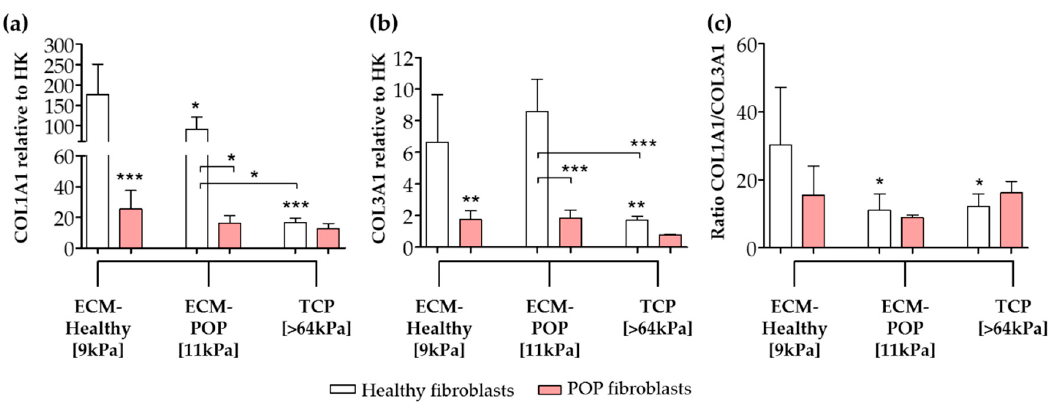
Figure 5. Gene expression of collagens of vaginal fibroblasts on di ff erent micro-environments. Healthy or POP fibroblasts were seeded for 48 h on di ff erent micro-environments: ECM-Healthy (vaginal decellularized extracellular matrix from healthy tissues), ECM-POP (vaginal decellularized extracellular matrix from pelvic organ prolapse tissues) or TCP (tissue culture plates). The graphs show the relative gene expression to house-keeping genes (HK) of collagen I (( a ); COL1A1 ) and collagen III (( b ); COL3A1 ). ( c ) Ratio of collagen I / III . Data represents the mean ± SD. * p < 0.05, ** p < 0.01, *** p < 0.001 by one-way ANOVA, followed by Tukey’s multiple comparison test.